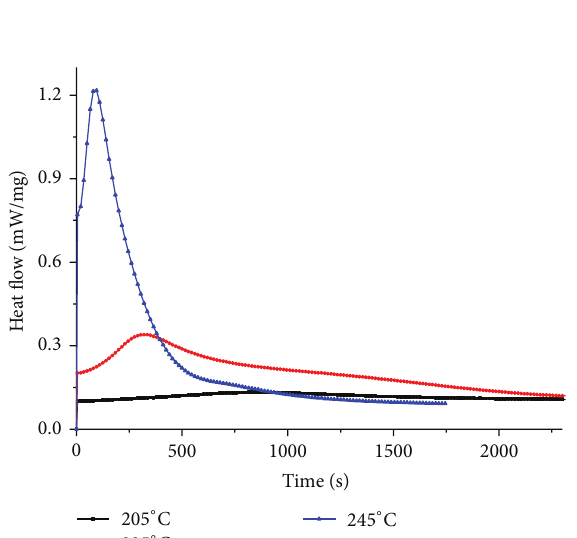
Scheme 3: The reaction between phenolic hydroxyl groups and F-51.